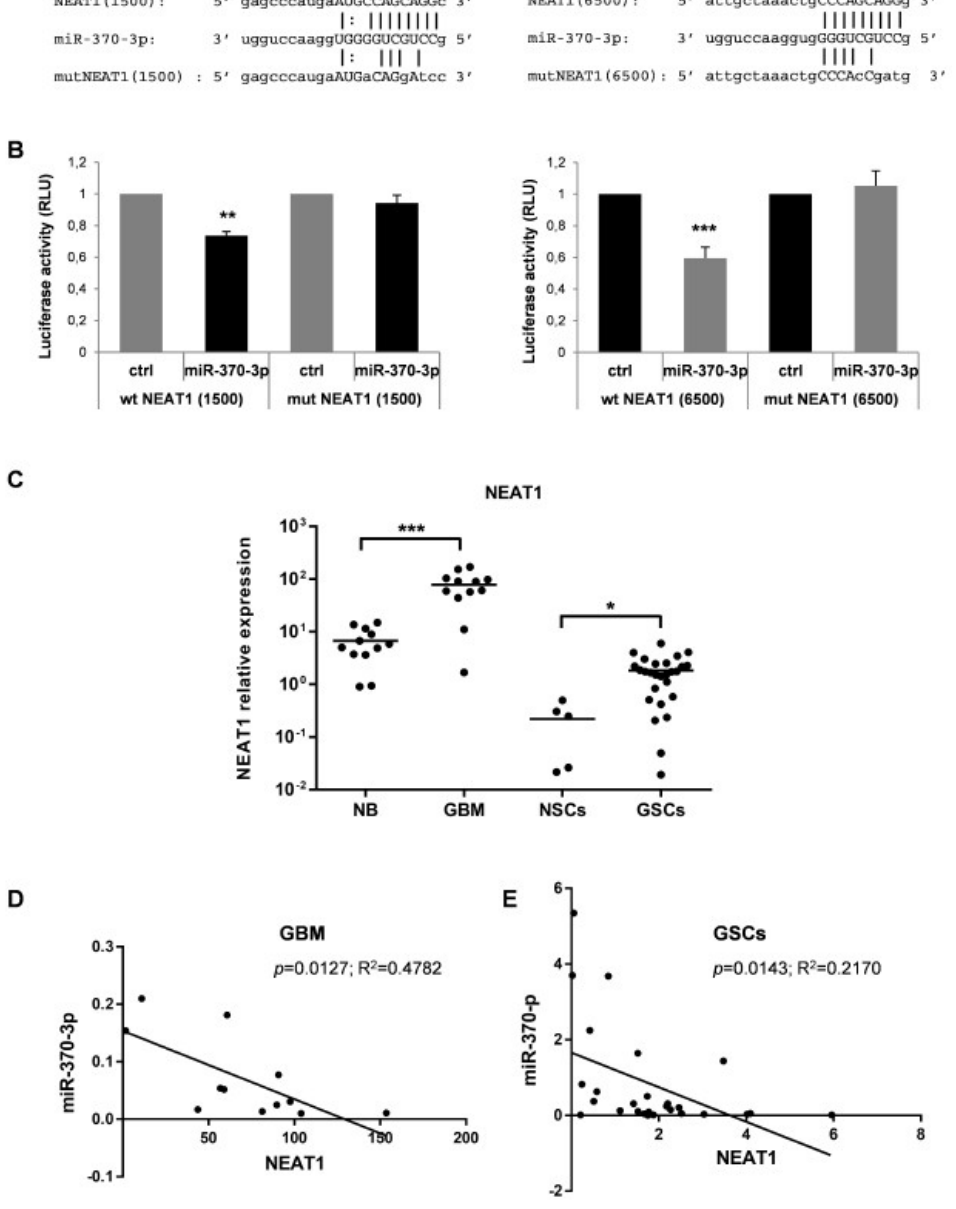
Figure 4. Nuclear Enriched Abundant Transcript 1 (NEAT1) is a target of miR-370-3p and its expression in GBM tissues and GSC lines is inversely correlated with miR-370-3p. ( A ) Binding sites between miR-370-3p and NEAT1 at + 1500 (left panel) and at + 6500 (right panel) nucleotides of RNA sequence. ( B ) Dual-luciferase reporter assays in 293T cells co-transfected with reporter vectors containing the wild type (wt) or the mutated (mut) NEAT1(1500) (left panel) or NEAT1(6500) (right panel) sequences and miR-370-3p-mimic or control mimic RNA (ctrl). Bar charts show normalized mean values of the relative luciferase activity. Error bars represent the mean ± SD ( n = 4) (student t-test: ** p < 0.01; *** p < 0.001. ( C ) RT-PCR analysis performed on normal brain samples (NB, n = 12), GBM tissues (GBM, n = 12), NSCs ( n = 5) and GSCs ( n = 27). Samples were run in duplicate and normalized with GAPDH. * p < 0.05; ** p < 0.01; *** p < 0.001. ( D ) Correlation analysis between miR-370-3p and NEAT1 expression levels in GBM tissues and ( E ) in GSC lines.